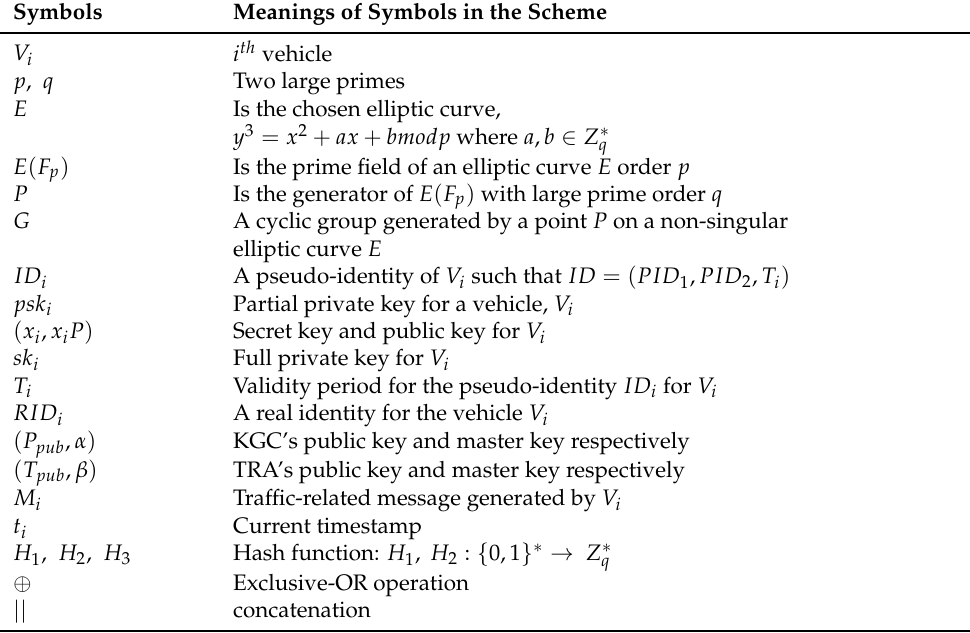
Table 1. Notations Used in the Proposed Scheme. Symbols Meanings of Symbols in the